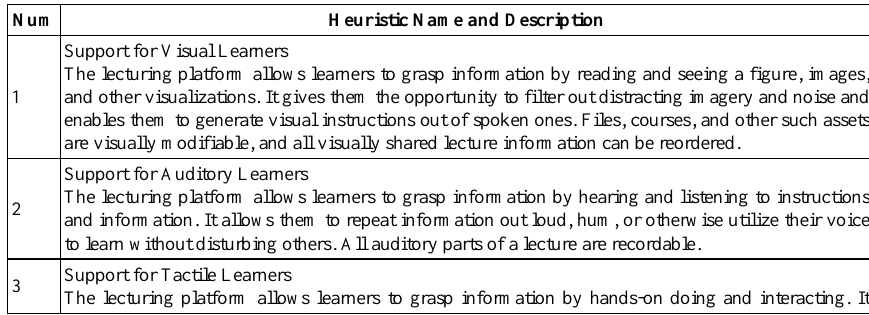
Table 2. Category -2- Heuristics - learning style